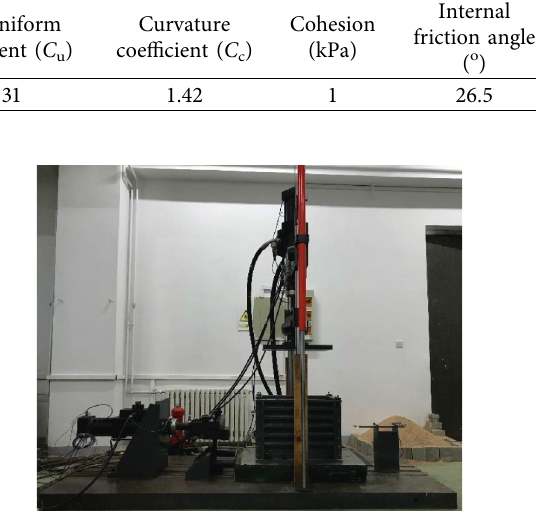
Figure 3: The pullout test equipment.